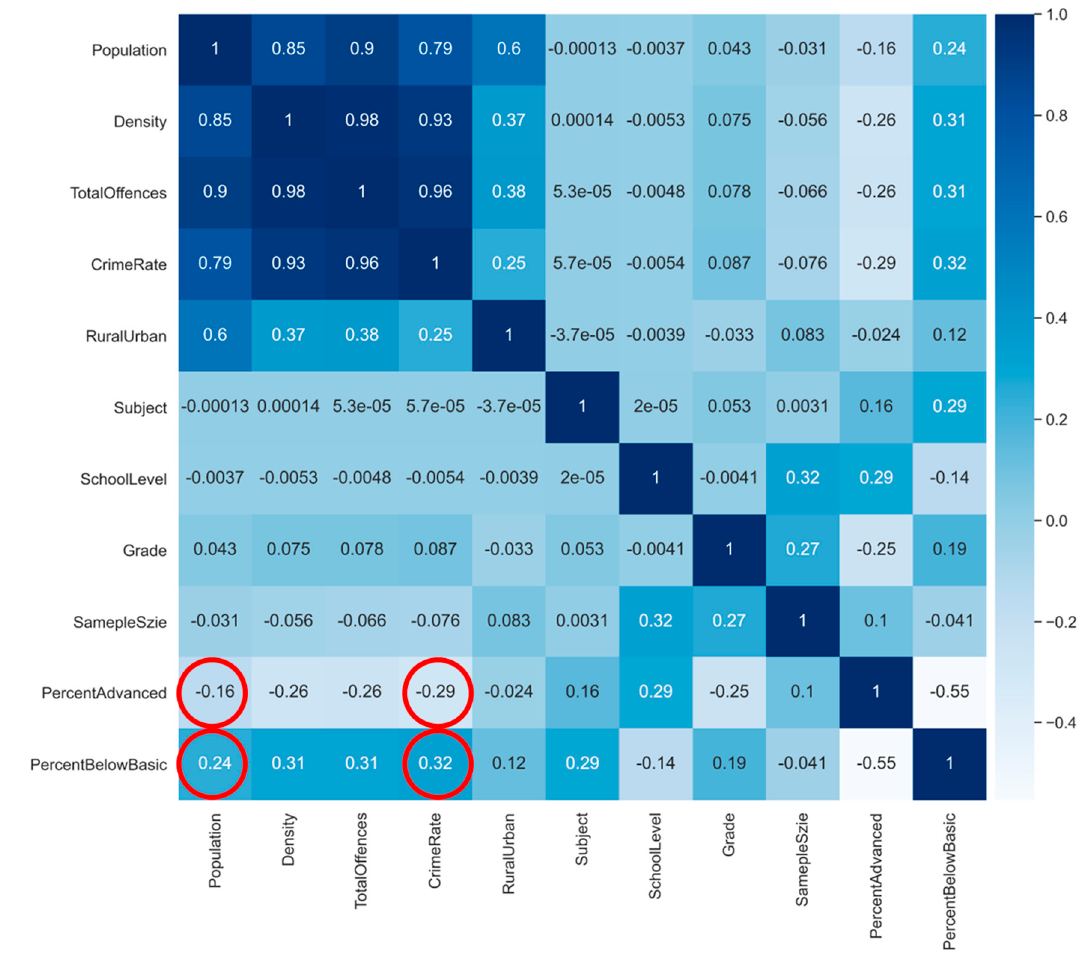
Figure 2. Heatmap analysis showing the relationship between “Area”, “Population”, “Density”, “Total offences”, “Crime rate”, “Rural or urban”, “Grade”, “School level”, “Sample size”, “Subject”, “Percentage of advanced students”, and “Percentage of below-basic students”. The darker the color, the stronger the positive correlation between the two data sets. The lighter the color, the stronger the negative correlation between the two data sets. The red circles visually represent the focal points of this paper’s target analysis, namely the relationships between “Percentage of advanced students”, “Percentage of below basic students”, “Population”, and “Crime rate”.